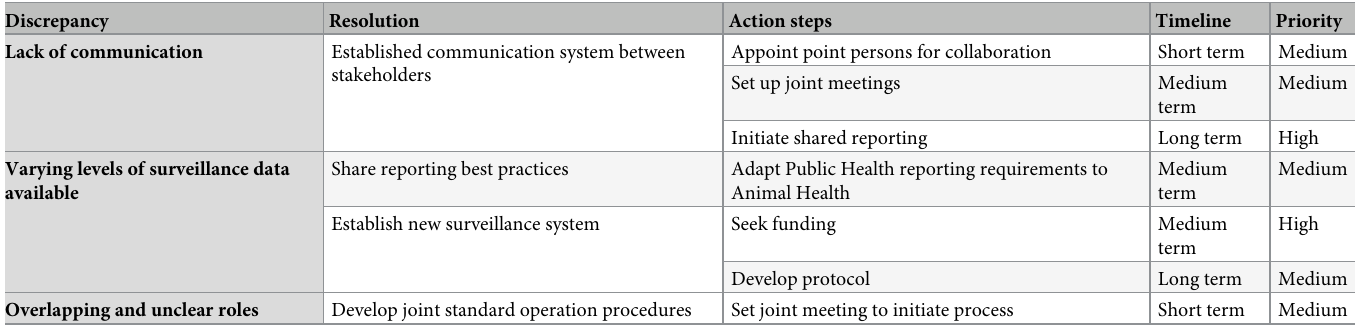
Table 2. OH-SMART workshop action plans. Example of action plans developed by workshop participants during multi-stakeholder workshops to resolve identified discrepancies.